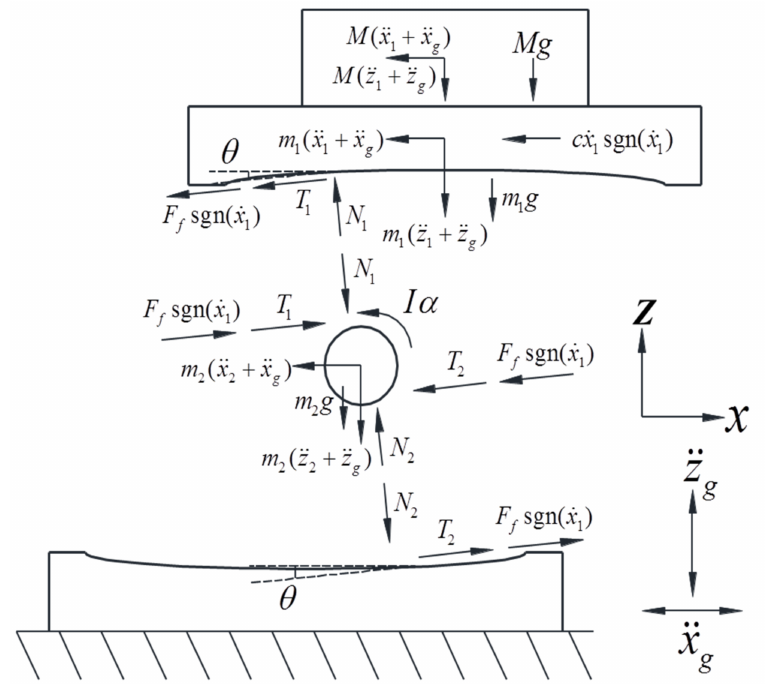
Figure 3. The free body diagram of the